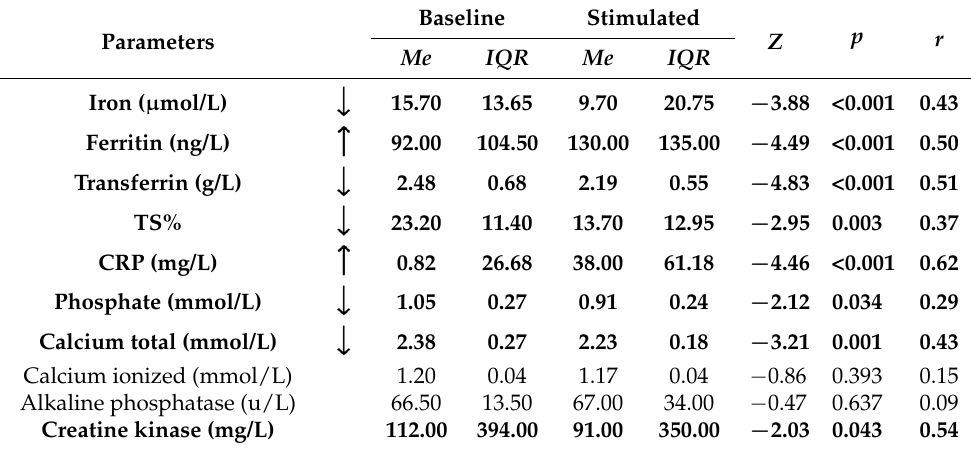
Table 1. Comparison of selected biochemical parameters before and after electrical stimulation in DBS and SCS groups. Parameters in bold were significantly different. Trend arrows show the change of examined parameters.